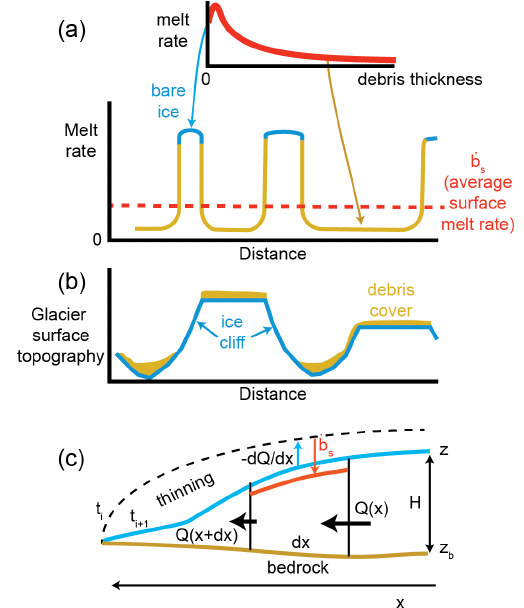
Figure 3. Schematic comparing the relative roles of ice cliff back- wasting, sub-debris melt, and ice emergence to the lowering of an idealized glacier terminus. (a) Idealized relationship between ice cliff backwasting and sub-debris melt. Note that the inclination and low albedo of ice cliffs can lead to melt rates that exceed bare-ice melt rates on a flat surface. (b) Glacier surface topography with de- bris cover and ice cliffs compared to melt rates in (a) . (c) Schematic showing the relationship between surface melt, ice dynamics, and the thinning of the glacier through